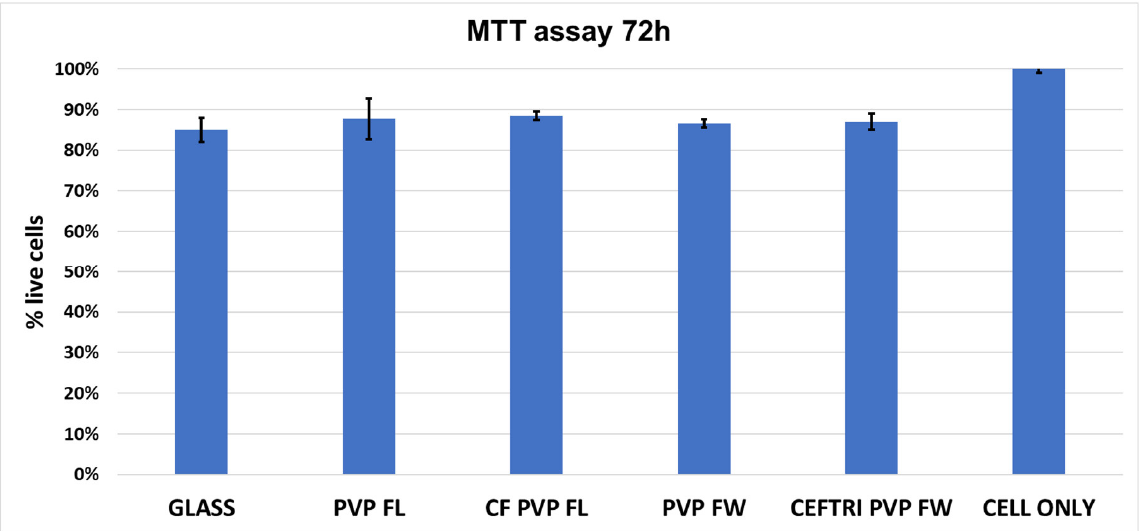
Figure 9. Cell viability of human endothelial cells after 72 h on the biopolymeric coatings. After 3 days in the presence of isoflavonoid-antibiotic thin films, the endothelial cells showed normal morphology with endothelial-like characteristic appearance (Figure 10).